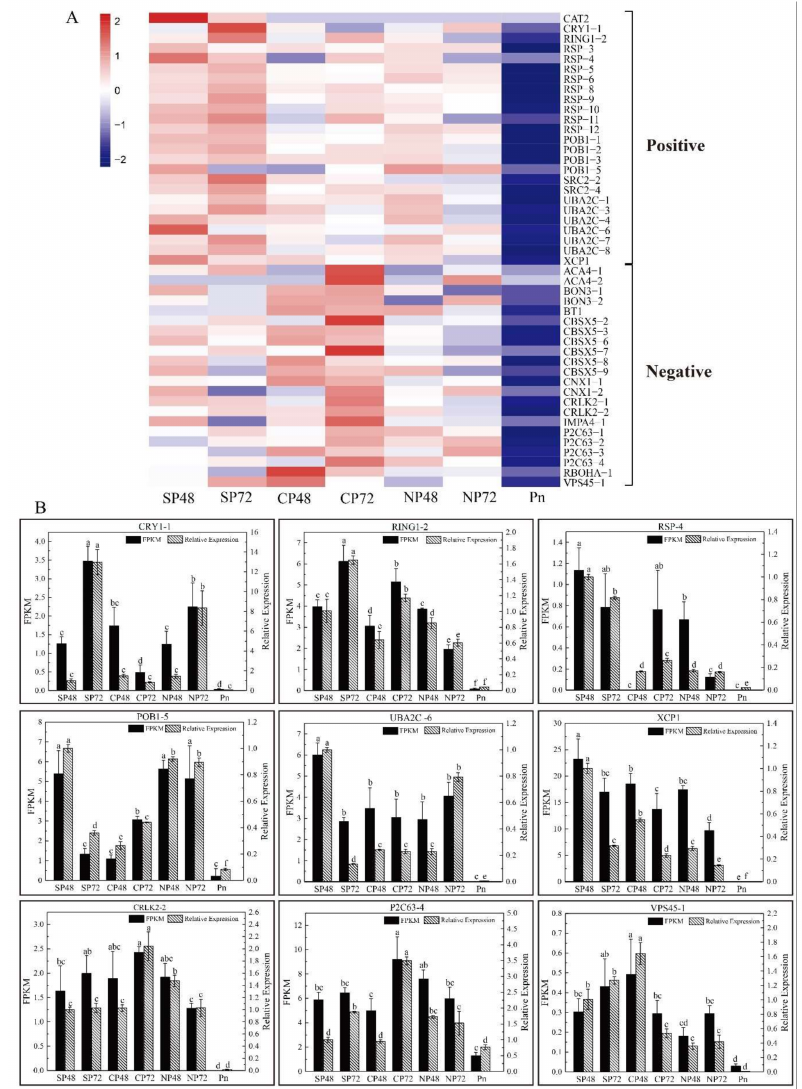
Figure 5. Expression patterns of programmed cell death (PCD)-related genes in self-, cross-